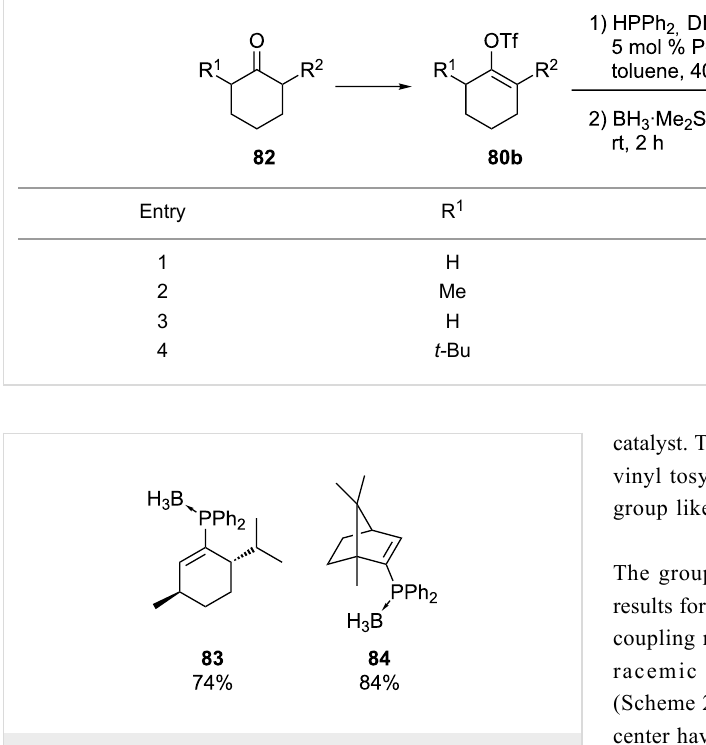
Julienne et al. succeeded in coupling vinyl tosylates 85 and 87 with diphenylphosphine borane 13e despite the fact that alkenyl tosylates are poor reagents for cross-coupling [164]. The prod- ucts 86 and 79b were formed in the presence of a